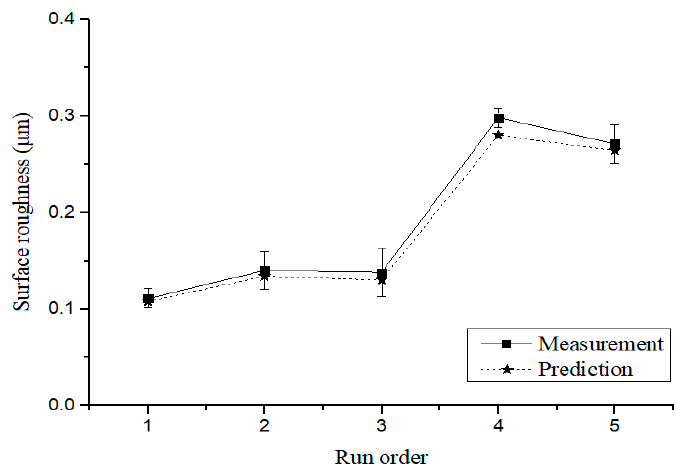
Figure 11. Comparison of the results of the prediction equation and the verification experiments for the surface roughness.